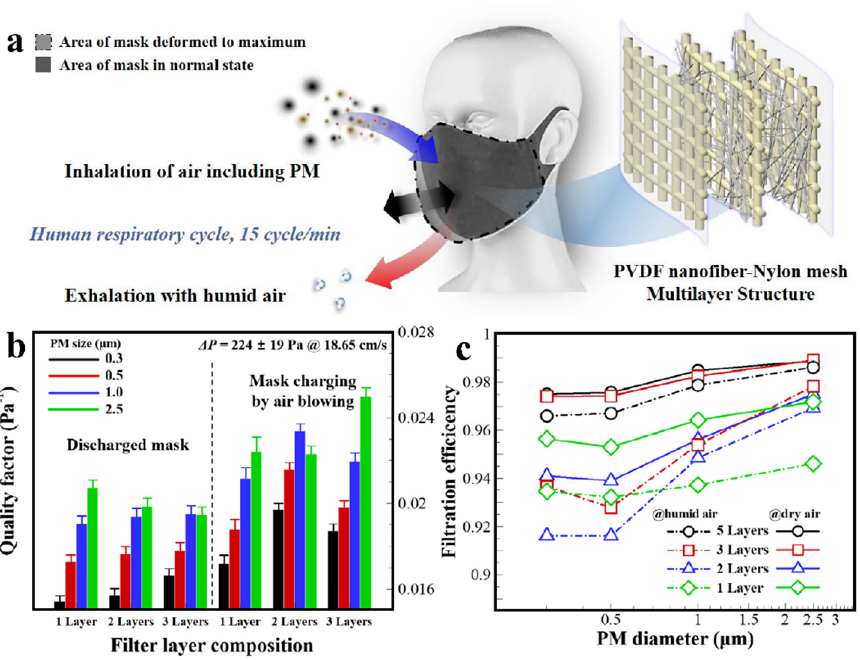
Figure 5. ( a ) Schematic for filter charging via bending and fluttering by air blowing, mimicking human respiration. ( b ) QF of the melt-blown PP layer-covered multilayer NF filter depending on discharged and charged states. ( c ) Persistence of filtration efficiency of the multilayer NF filter after continuous dry or humid air penetration for 0.5 h.